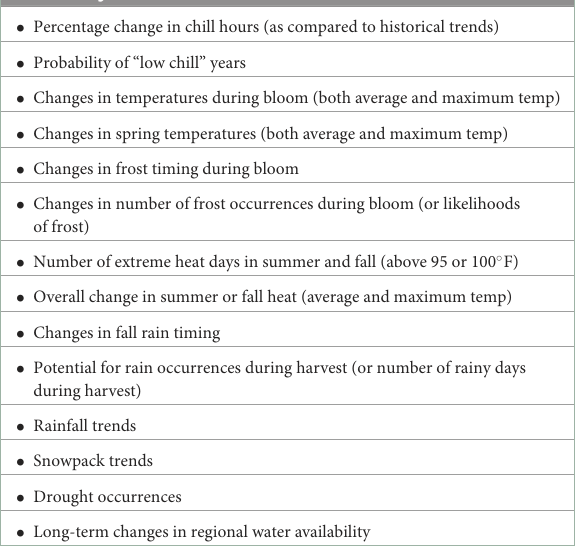
TABLE 3 The types of long-term climate projections that were identified as actionable by farmers. Types of long-term climate projections identified as useful by